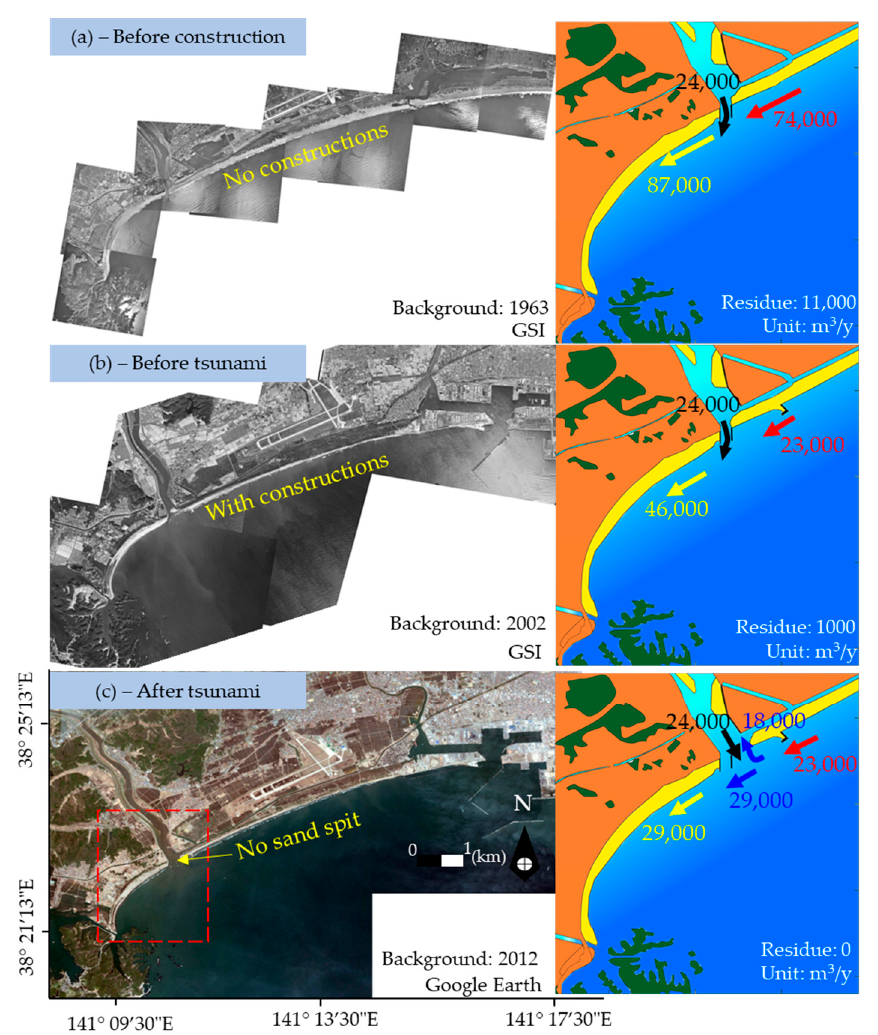
Figure 15. Centennial-to-decadal sediment budget in the Nobiru Coast. ( a ) Period 1: Before construction. ( b ) Period 2: Before the 2011 tsunami. ( c ) Period 3: After the 2011 tsunami.